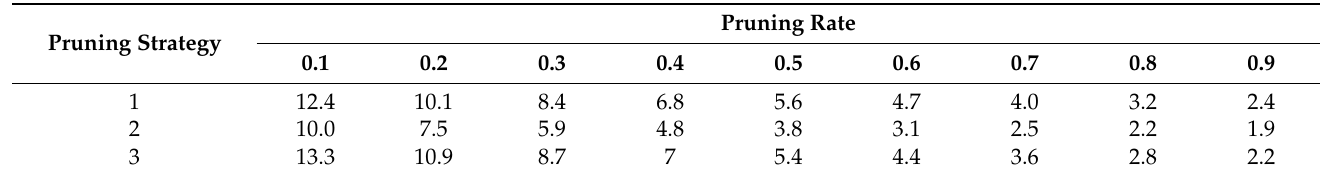
Table 5. Computational statistics of the network model after pruning (/GFLOPs).